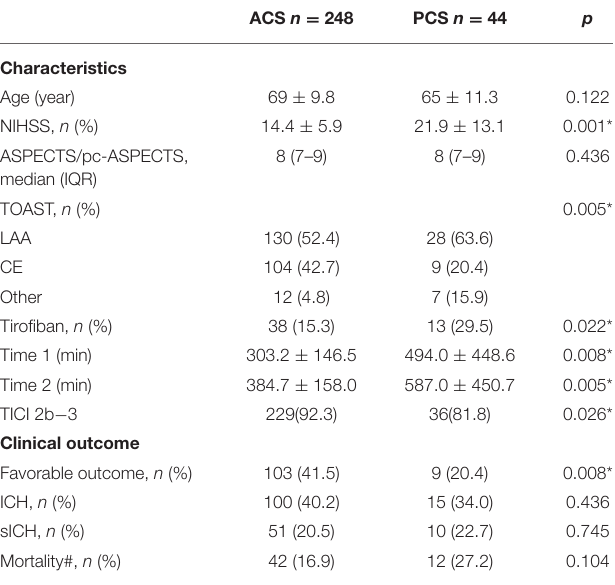
TABLE 3 | Patient characteristics and outcomes on patients with ACS and PCS.